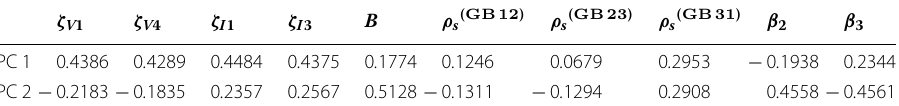
Table1 Variable loadings for the first and second principal components